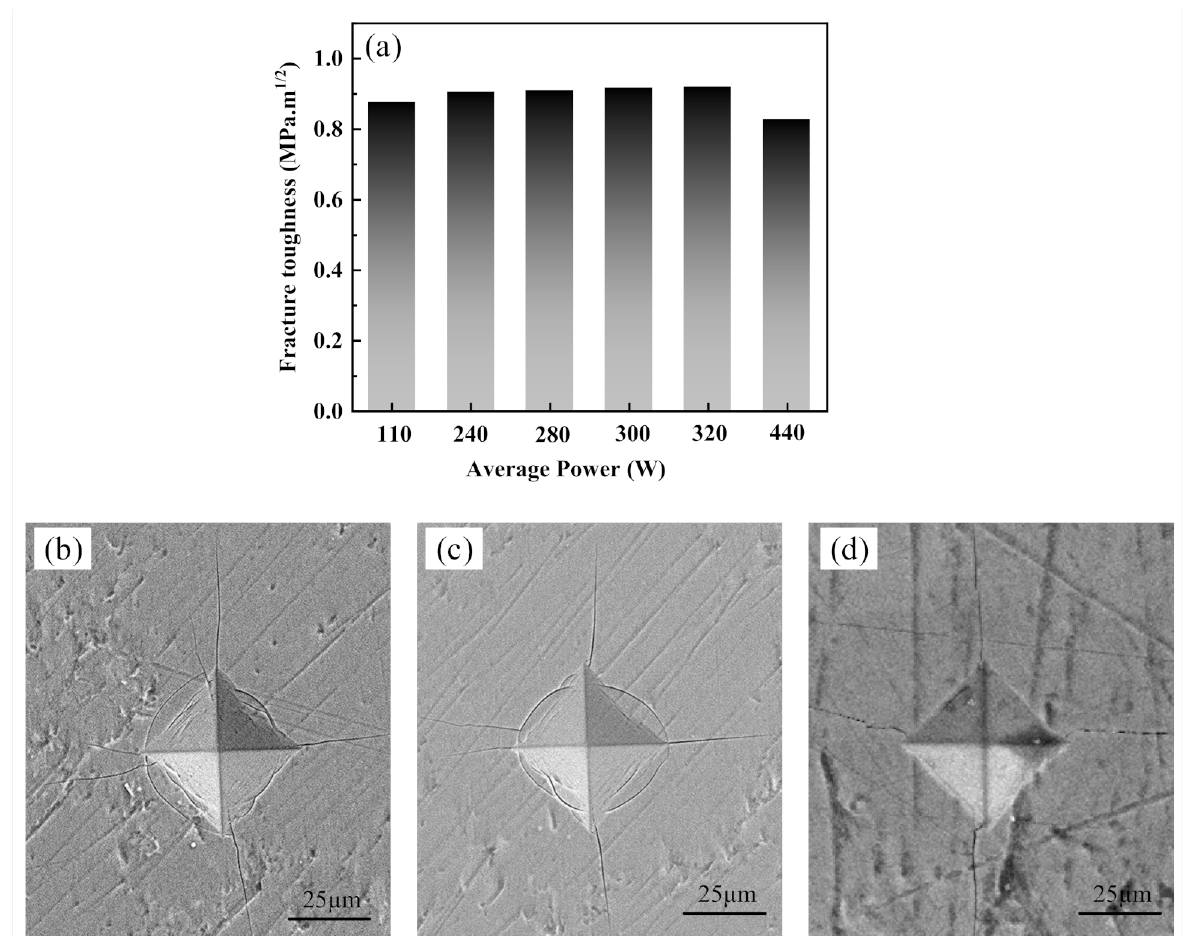
Figure 11. ( a ) Fracture toughness of the Cr 2 AlC MAX coatings deposited at different average power in HiPIMS and SEM micrographs of indentation formed for the coatings at P ave of ( b ) 110 W ( c ) 300 W, and ( d ) 440